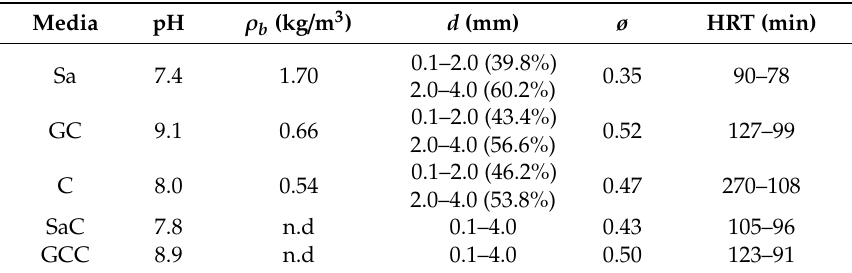
Table 1. Specifications of the filter media.